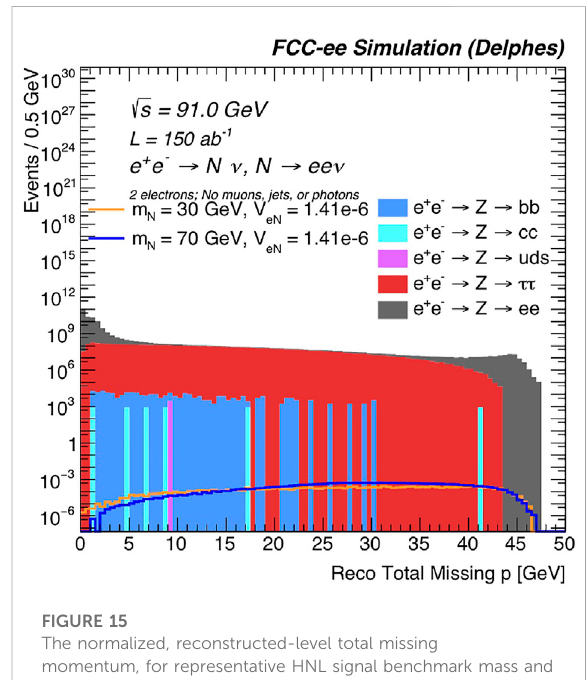
FIGURE 15 The normalized, reconstructed-level total missing momentum, for representative HNL signal benchmark mass and | V eN | choices, as well as background processes. Exactly two